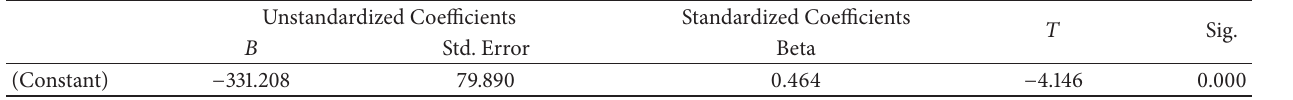
Table 11: Coefficients in Figure 3.